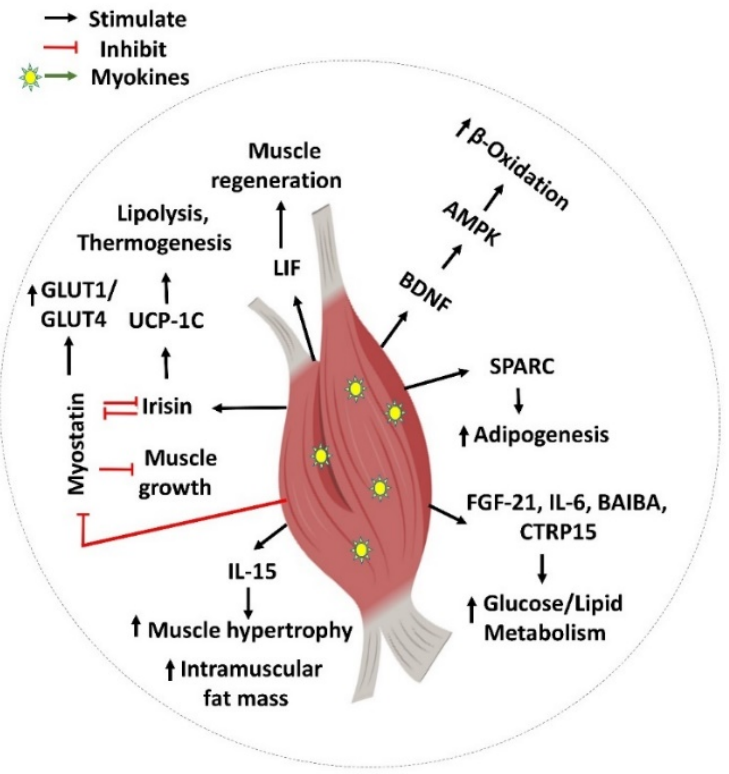
Figure 1. Myokine-mediated regulation of skeletal muscle function. Myokines such as SPARC, FGF-21, IL-6, BAIBA, CTRP15, BDNF, LIF, Irisin, myostatin (GDF-8), and IL-15 are involved in various biological processes including muscle generation, adipogenesis, muscle hypertrophy, muscle growth, and glucose and lipid regulation locally inside the skeletal muscle. This figure was created with Biorender.com.